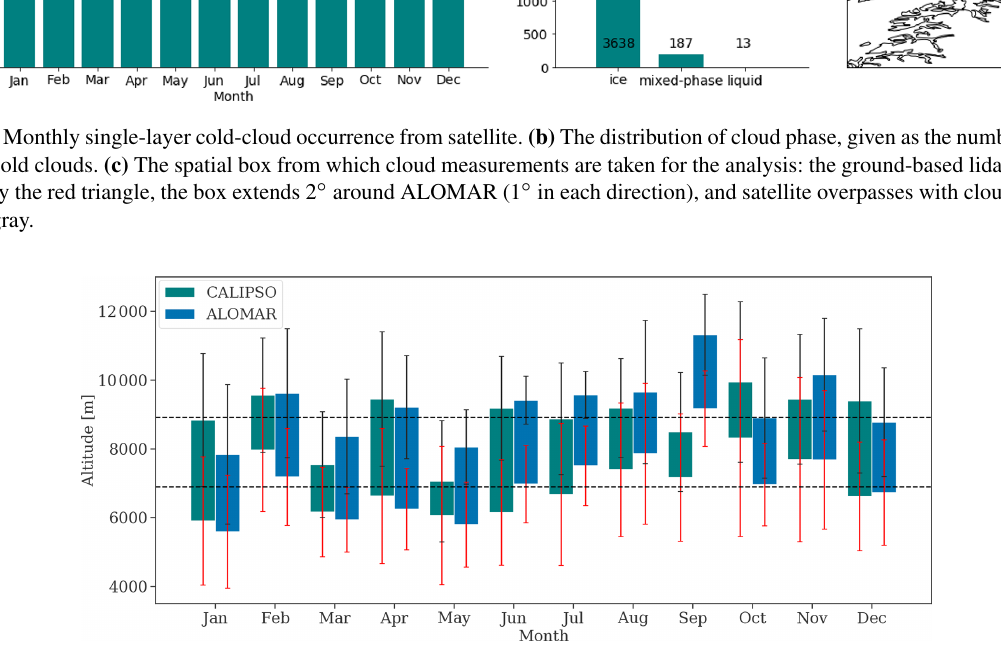
Figure 6. Monthly mean thickness of cirrus clouds observed from the ground-based lidar at ALOMAR (blue) and CALIOP (green). The error bars indicate the standard deviation of the computed cloud top and base heights. The dashed black lines show the multiyear annual